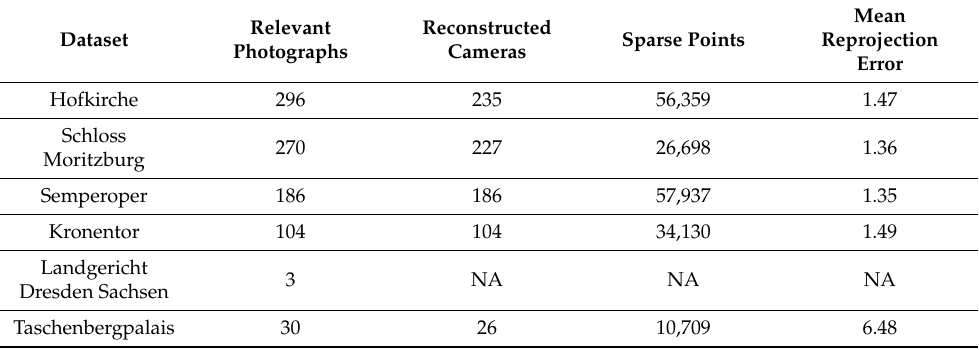
Table 3. Results of the SfM processing in COLMAP using the SuperGlue feature matching. For all datasets, almost all relevant photographs can be oriented in a single reconstruction with reasonable mean reprojection errors. For the Landgericht dataset with only 3 relevant images, reconstruction is not